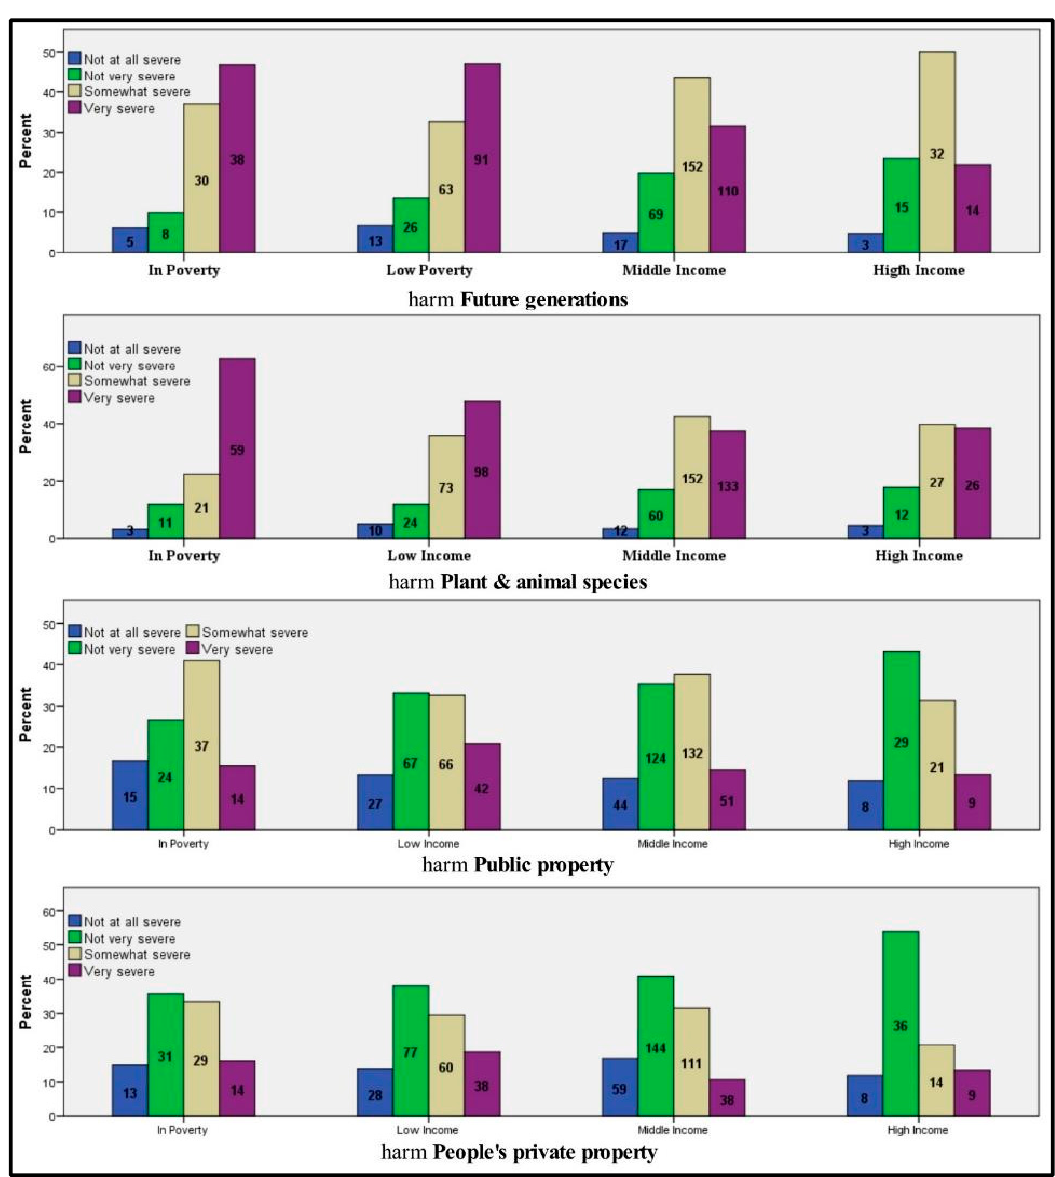
Figure A1. Different income groups concerns about future impacts of heat waves based on different subjects.